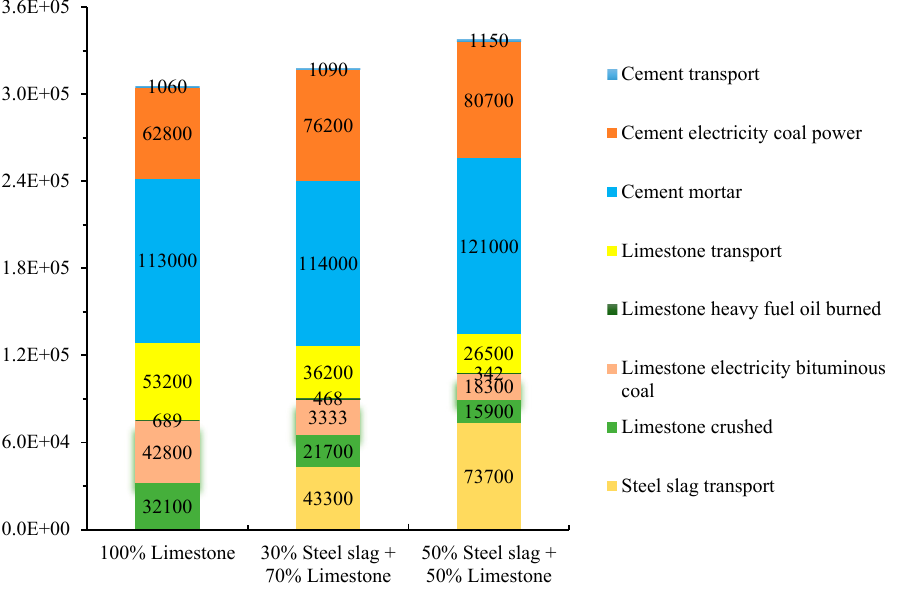
Figure 18. Detailed CO 2eq emissions for each procedure.